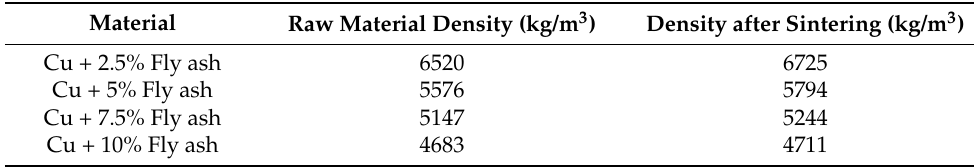
Table 1. The density of raw material and material after